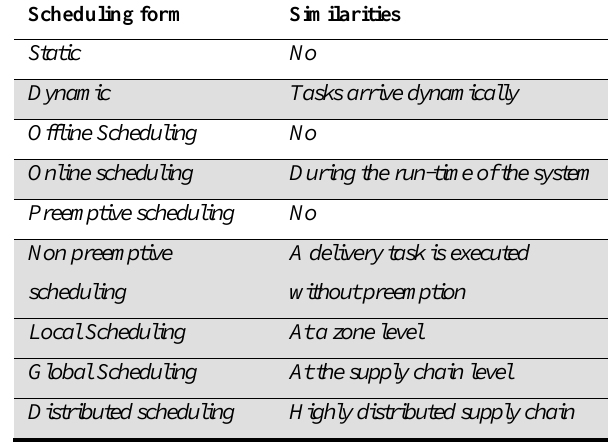
Table 2. Comparison with existent forms of